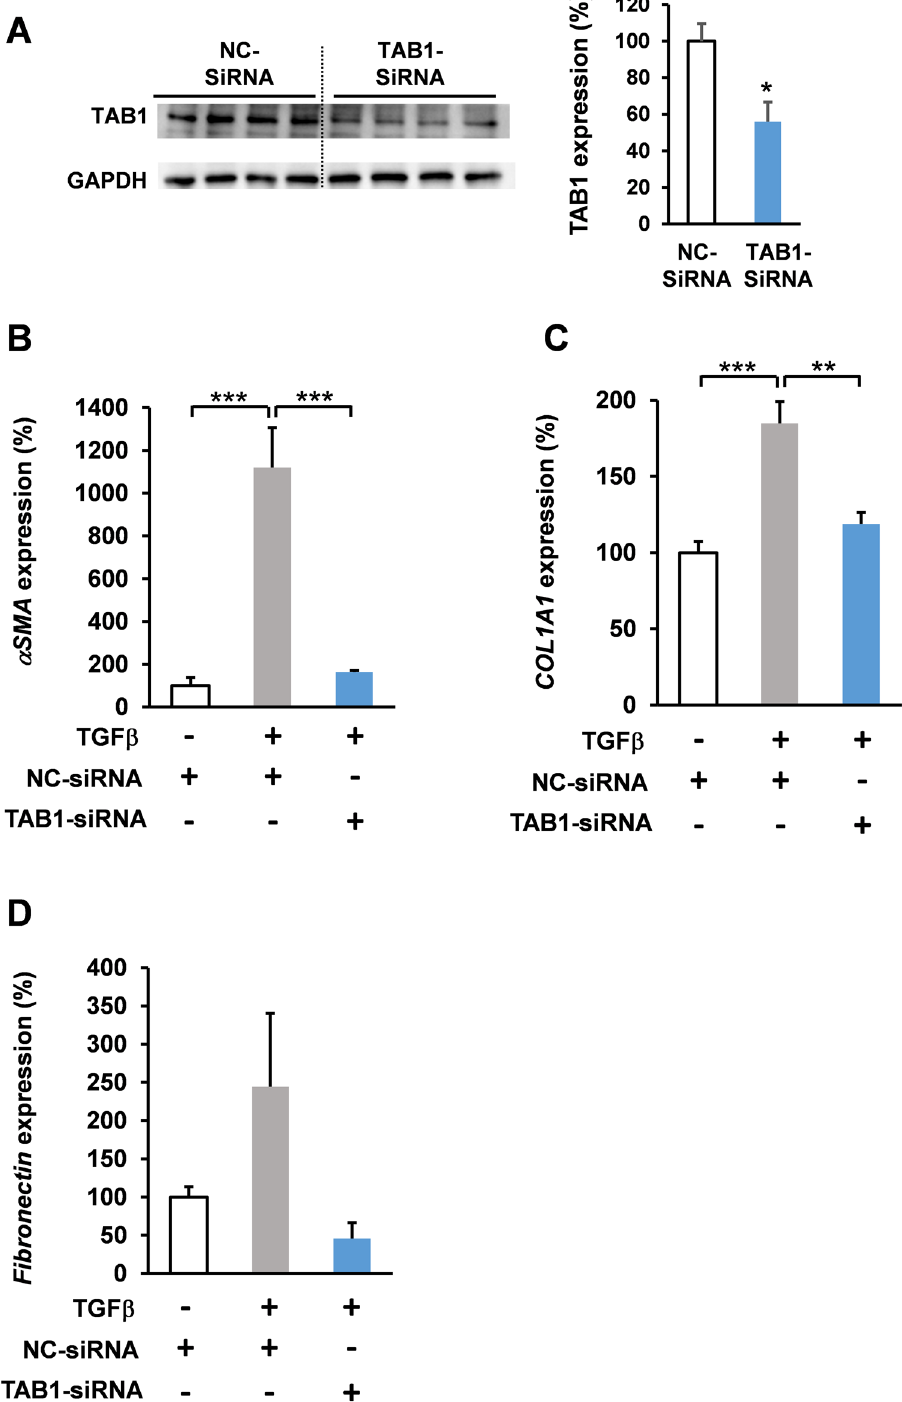
Figure 3. TAB1 knockdown suppressed TGFβ-induced fibrotic gene expression. ( A ) Human lung fibroblast HFL1 cells were transfected with TAB1-siRNA (10 nM, 48 h) and TAB1 expression levels were determined by western blot analysis. ( B – D ) Human lung fibroblast HFL1 cells were transfected with TAB1-siRNA (10 nM, 48 h) and treated with TGFβ (5 ng/mL for B , D 48 h; C 24 h). mRNA expression levels were assessed via RT-qPCR. ( B ) ASMA (αSMA) (n = 4), ( C ) COL1A1 (n = 4), and ( D ) FN (fibronectin; n = 4). Data are shown as mean ± SEM. * P < 0.05. ** P < 0.01. *** P < 0.001 versus control